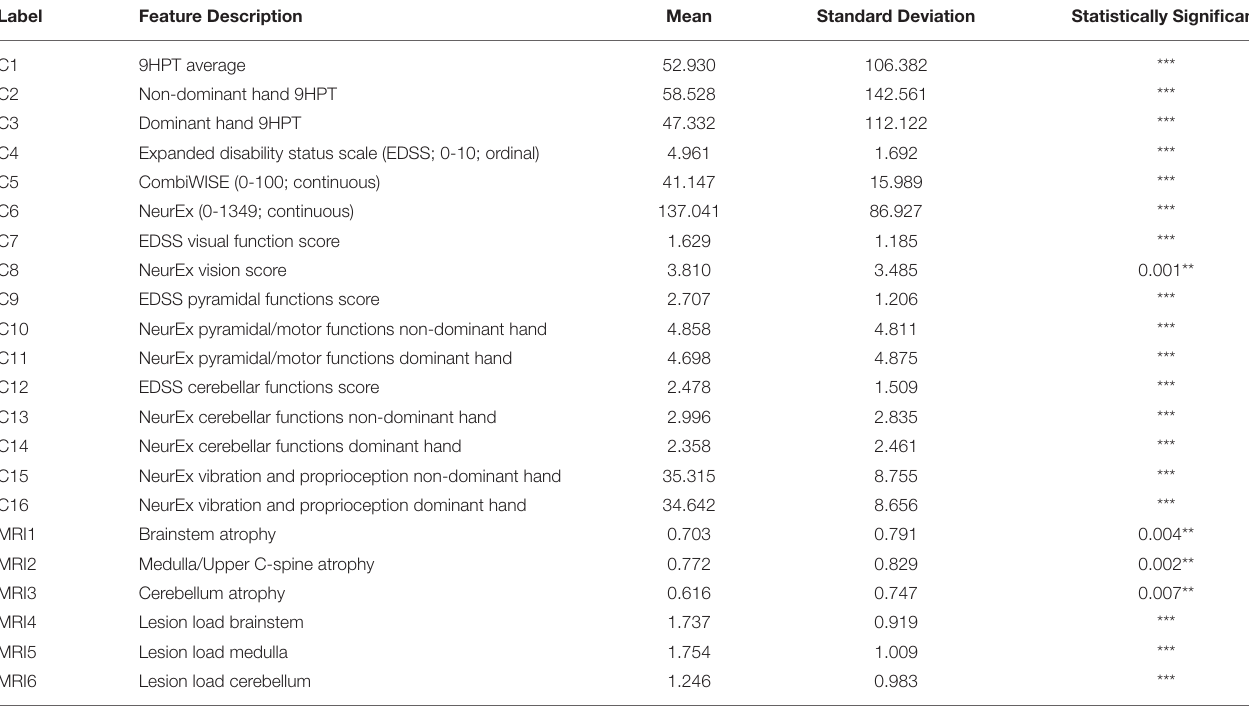
TABLE 2 | List of clinical disability scales used in the study.